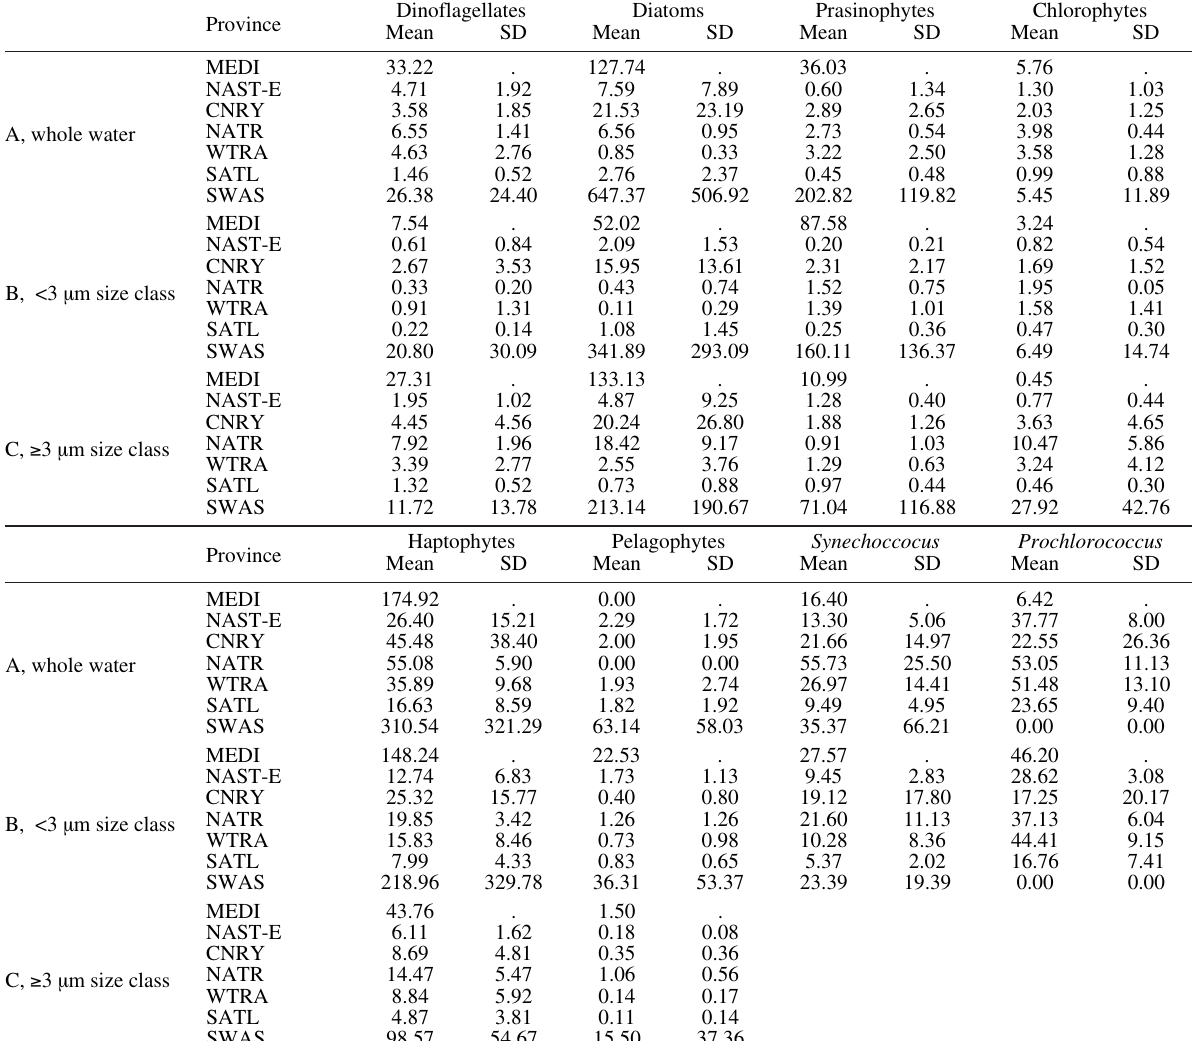
Table 5. – Average (±SD) values of the Chl a contribution of the chemotaxonomic phytoplankton groups considered in this study for the various provinces. For province names, see the explanation in Figure 1.